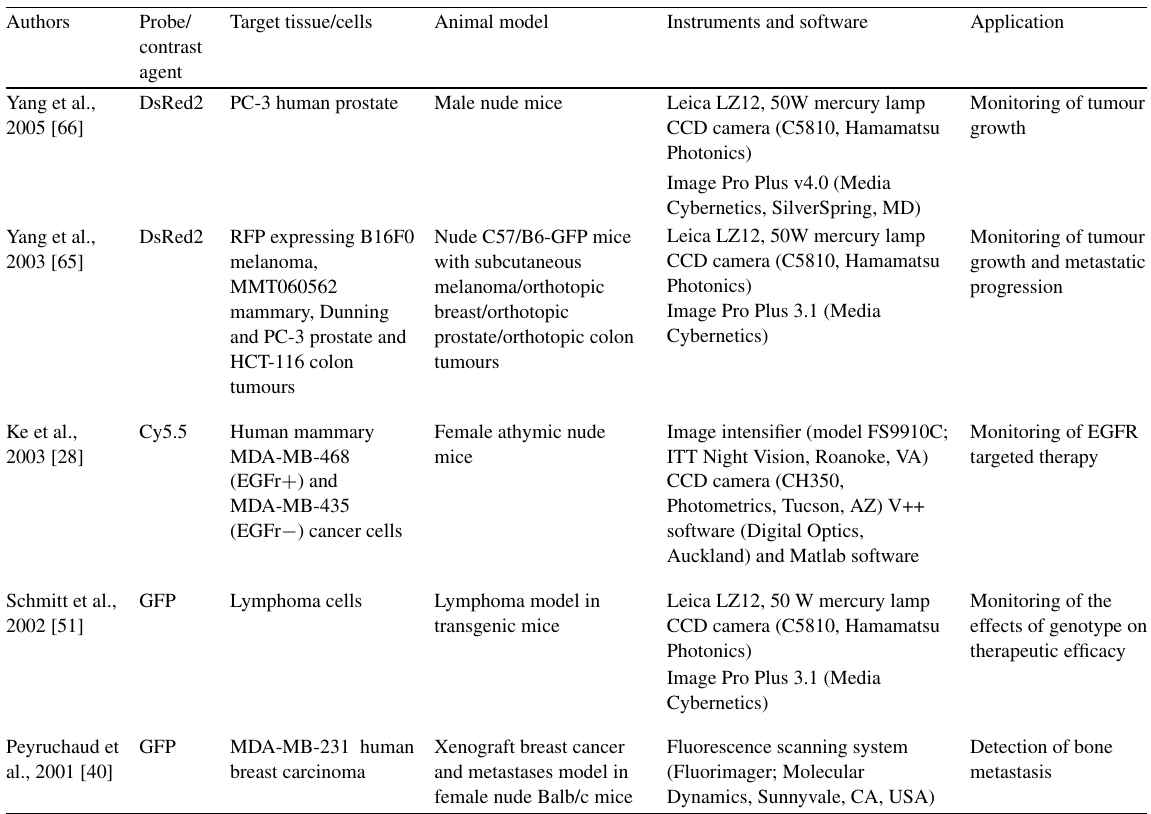
Fig. 4. (A) Whole-body fluorescence imaging of 2 weeks post-surgical implanted orthotopic PC3-DsRed primary prostate tumour (arrowhead) and metastasis in nude mice (arrows). (B) Image of the same animal 4 weeks later showing progressive tumour growth (arrow head) and extension of metastases (arrows) [66]. Summary of Fluorescence Imaging application and